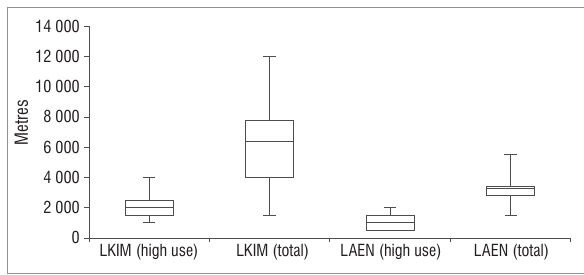
Figure 2: Graphical representation of the kernel size (kernel) and maximum displacement or area use of adult Labeobarbus kimberleyensis (LKIM) and L. aeneus (LAEN) in the Vaal River. Box-and-whisker plots include the 25th and 75th percentiles (boxes) and 5th and 95th percentiles (whiskers) of area use.